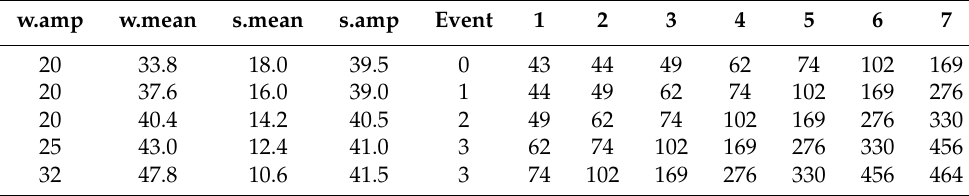
Table 3. Example of aggregated data for forecasting of seven days ahead.